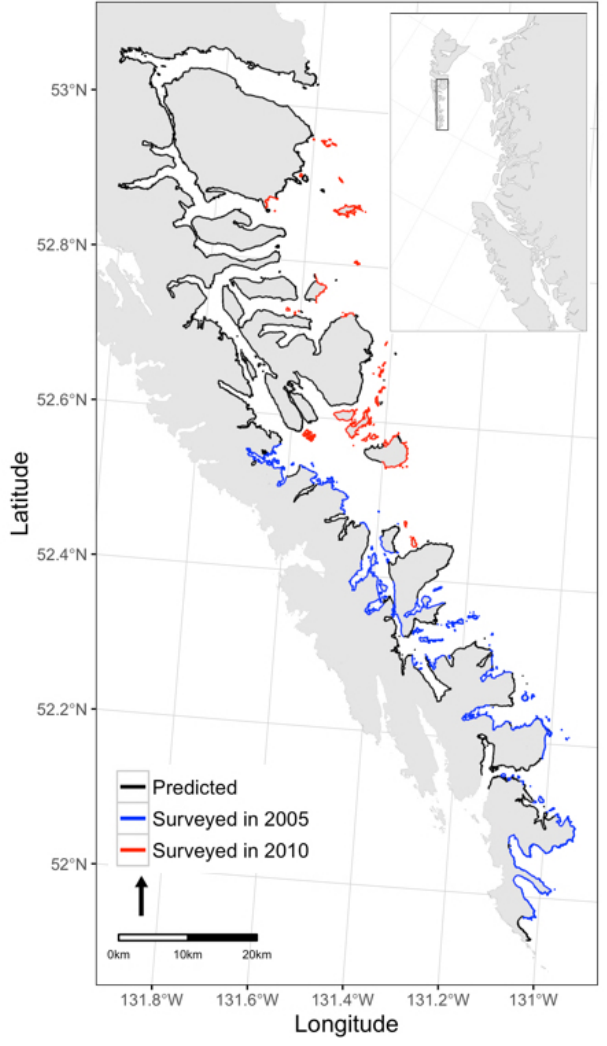
(over 20% 0–20 m), high wave exposure, high subsurface relief, low current speeds, and a mixture of sand and hard bottom substrate (Zacharias et al. 1998). Within the study area, the shoreline is primarily bedrock (38%) and mixed bedrock/sediment (26%; Howes et al. 1994). Of 846 islands in the study area, 80% are less than 1 ha, 32% are less than 0.1 ha, and 28% are forested. Dominant wind directions recorded at Cumshewa Island, the nearest weather station, are southeasterly and, to a lesser extent, northwesterly. Fig. 1 . Study area. Shoreline surveyed in 2010 is shown in red (Laskeek Bay and Juan Perez); shoreline surveyed in 2005 is shown in blue (Gwaii Haanas, south of Juan Perez); and unsurveyed shoreline over which breeding pair occurrence was predicted is shown in black. Inset shows study area in relation to Haida Gwaii and British Columbia